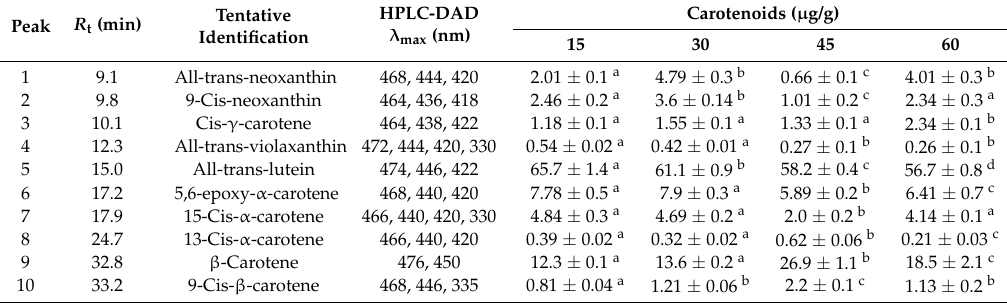
Table 2. Identification and changes in the Carotenoid contents of Apricot leaf samples. Identification was based on comparison with the absorption spectra of the standard compounds and data reported in the literature